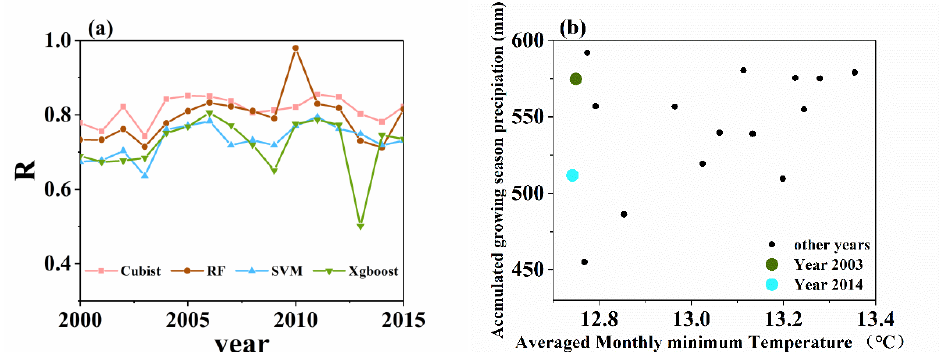
Figure 7. The leave-one-out experiment. ( a ) The performances of the different methods across 16 years. One-year data are selected for testing, while data from other years are utilized for training. ( b ) Scatter plot between the average monthly mean temperature and the accumulated growing season precipitation during the growing season across 16 years in